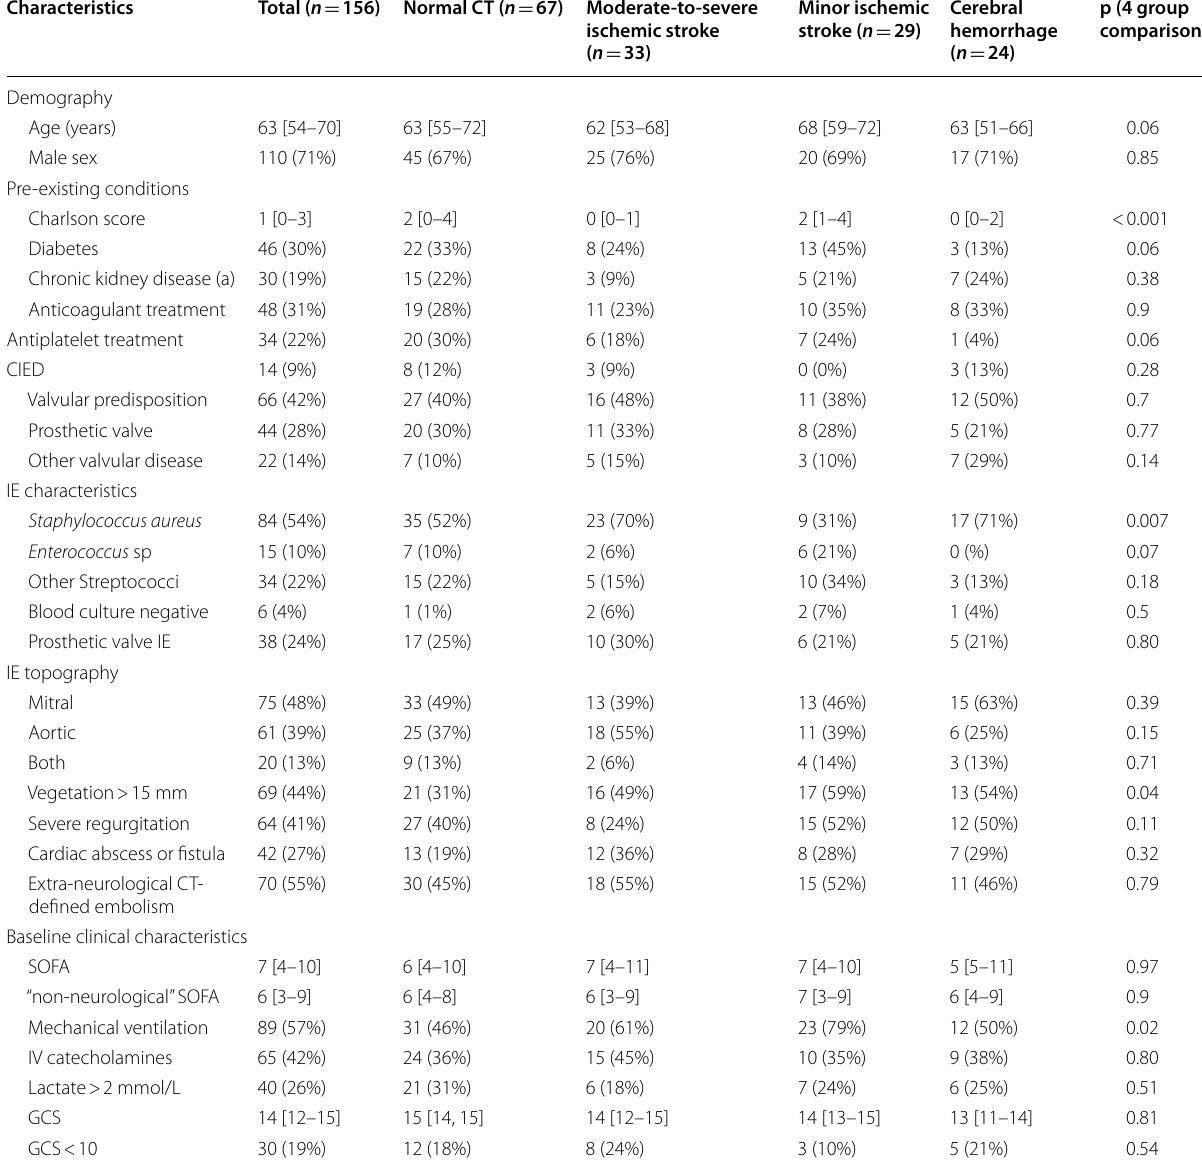
Table 1 Baseline